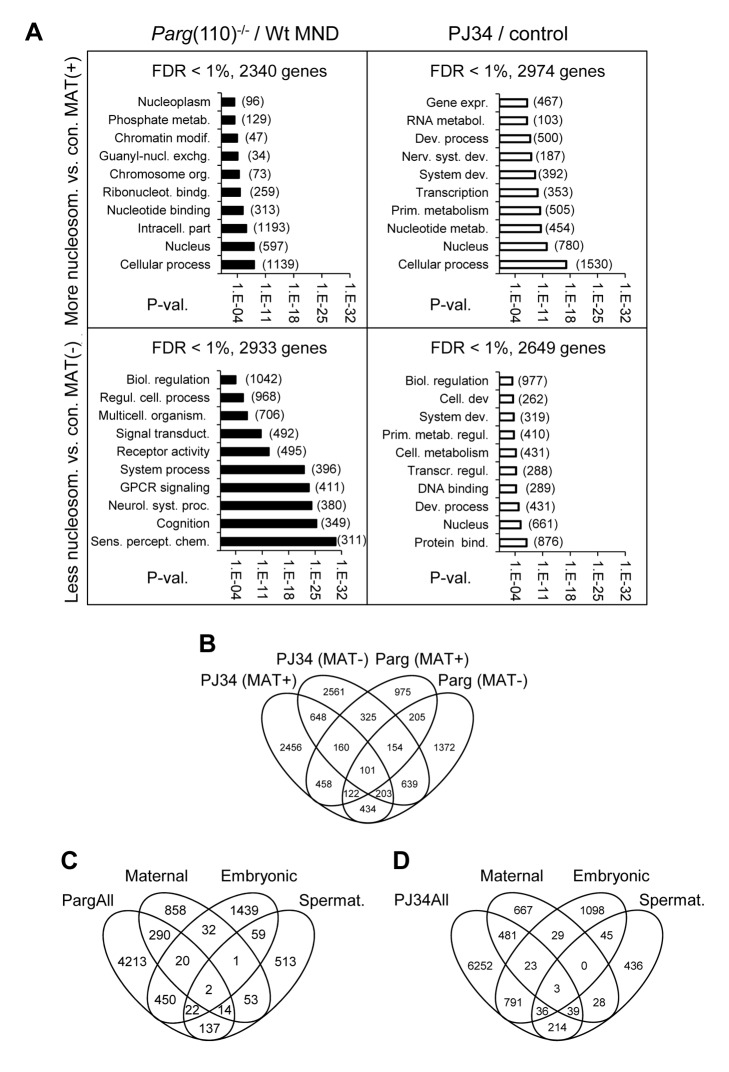
Perturbing PAR metabolism results in differential sperm histone association of gene loci with either excessive or reduced retention of nucleosomes.A) Functional GO-term enrichment of genes affected by elevated histone association (MAT(+)) or local failure to retain histones in regulatory gene sequences (MAT(−)) in sperm from Parg(110)−/− (left panels) and PJ34-treated males (right hand panels). The y-axis shows GO terms and logarithmic scale indicates their p-values of GO-terms returned by DAVID. False discovery rates (FDR) are indicated above the graphs. The numbers of genes in a given GO-term are in parentheses. (B) Overlaps of relative histone enrichment or deficiency in Parg(110)−/− or PJ34-treated mouse models compared to wild-type controls. (C, D) Comparison of genes that are differentially histone associated in Parg(110)−/− or PJ34 sperm with known maternal transcripts or newly expressed embryonic transcripts or spermatogenesis-specific genes indicates the potential relevance of aberrant histone association on genes expressed in the 2-cell embryo (Embryo). Maternal: transcripts present in 1-cell embryos prior to the major wave of genome activation [36]. The genes in the maternal, embryonic and spermatogenic groups are listed in Dataset S4 (MS Excel).